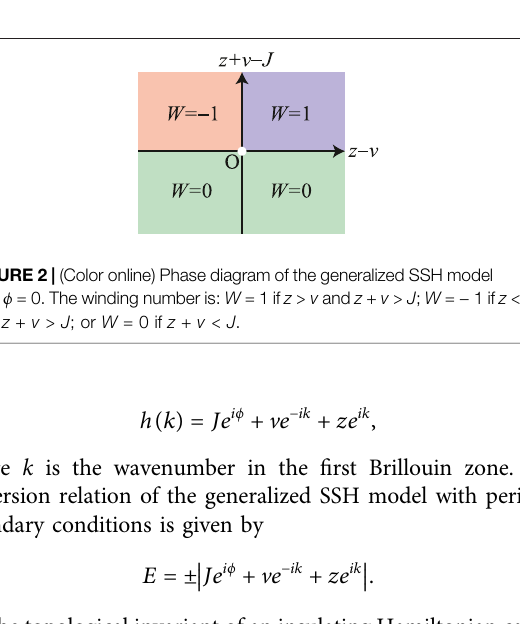
Frontiers in Physics |